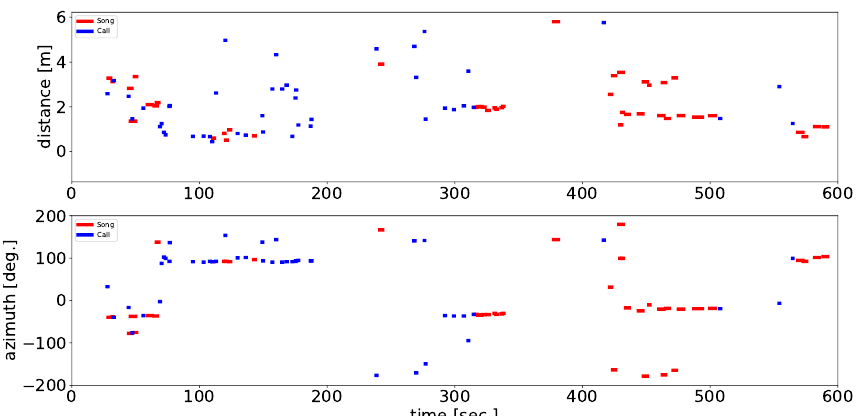
Figure 11. Changes in the azimuth and distance from the microphone array 4 (center) of each vocalization type. Red bars represent songs, and blue bars represent calls. The length of the bars corresponds to the length of each separated